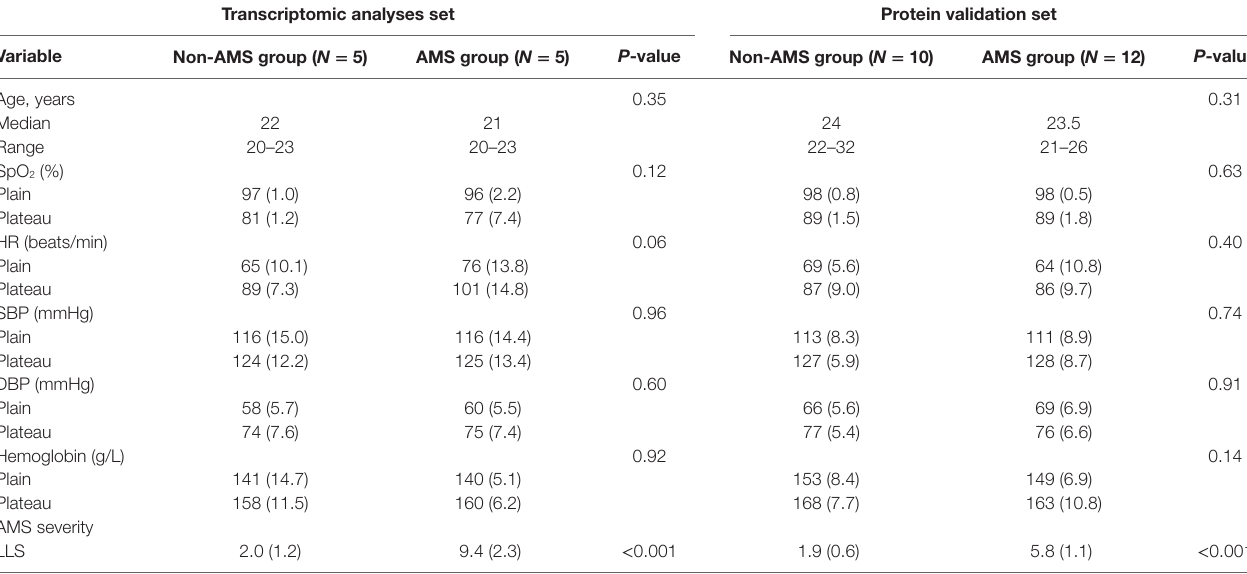
TaBle 1 | Demographic data and physiological indices of study subjects and comparison in aMs and non-aMs